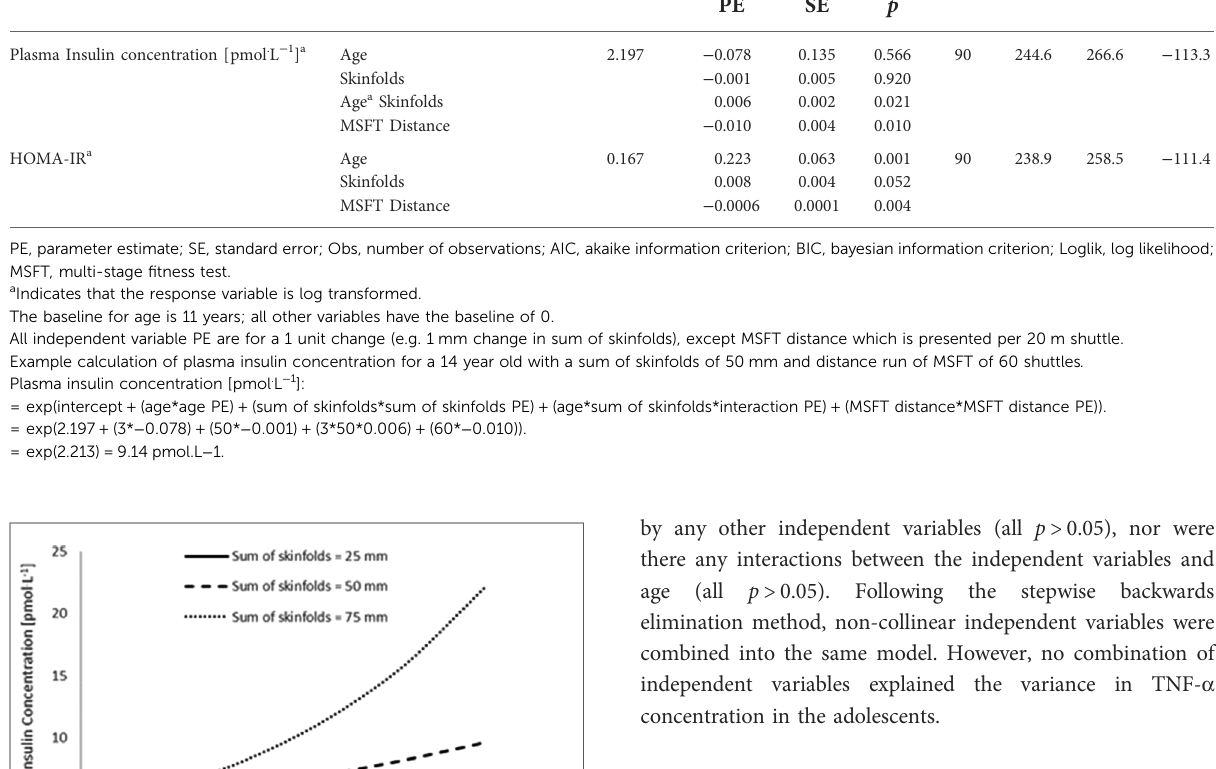
TABLE 4 Results of the multi-level models showing the combination of independent variables that best explained the variance in each response variable. Response Variable